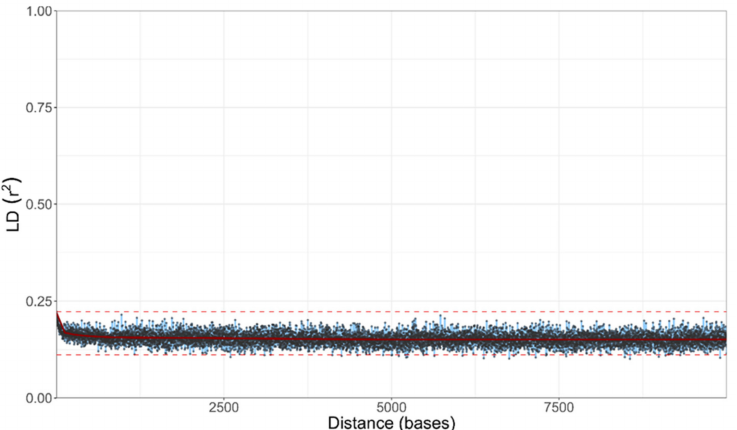
Figure 6. LD decay in A. melanogenum estimated on all biallelic loci, which were present in 25–75% of the sequenced genomes. LD measures were averaged in three nucleotide windows. Squared correlation coefficient (r2) between pairs of SNP loci plotted against the physical distance of the loci in the genome. Horizontal lines mark the maximum observed value and half of the maximum observed value. Vertical lines mark the interval of the physical distance in which the maximum value is